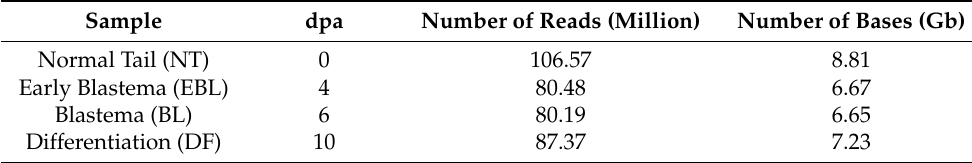
Table 1. Clean read